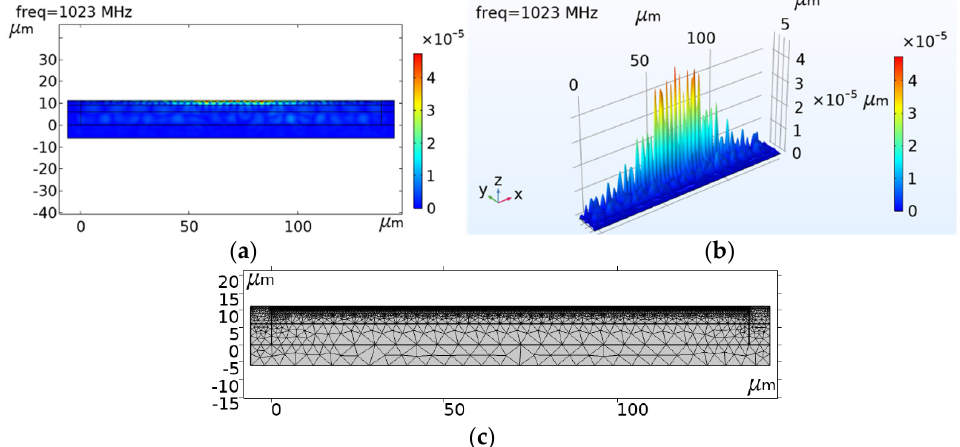
Figure 17. Simulation diagram of the total surface displacement of the model. ( a ) is a two-dimensional result and ( b ) is a three-dimensional result; ( c ) is the mesh density profile of complete structure, quadrilateral elements = 14319.